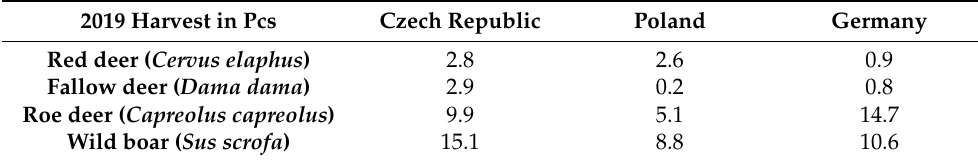
Table 3. Selected ungulates harvested per 1000 capita (comparison-adjusted per 1000 capita).